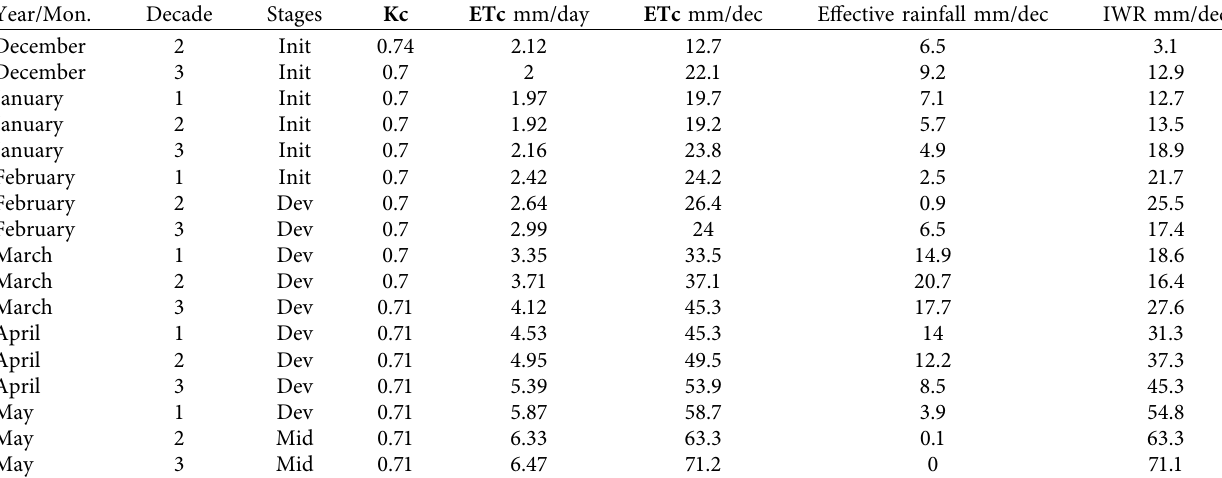
Table 4: CWR of citrus at different